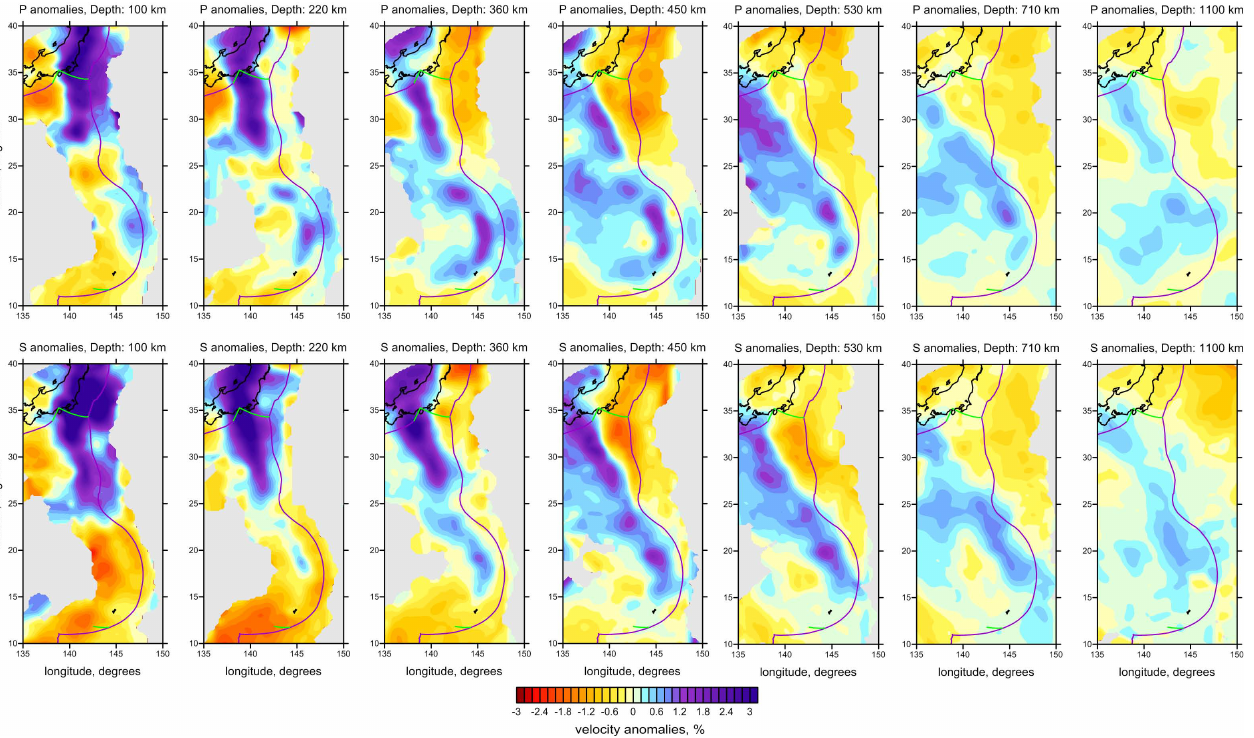
Fig. 3. The results of the real data inversion. The distribution of the P- and S-anomalies are shown at different depths. The purple line indicates tectonic boundaries according to Fig.